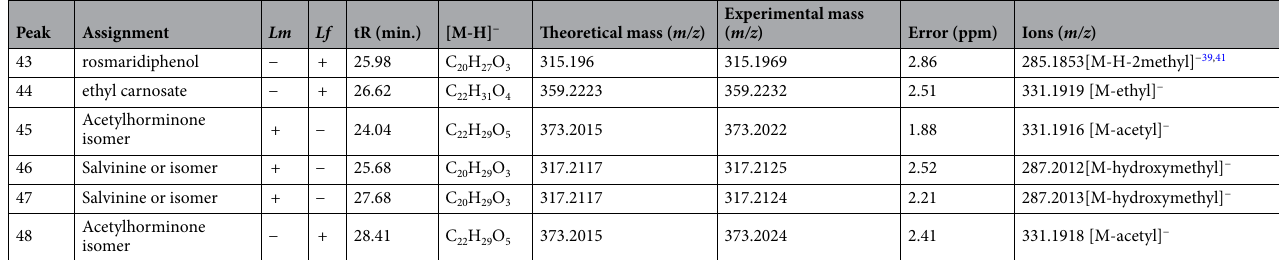
Table 1. Compounds detected in the ethanolic extract of Lepechinia meyenii Walp. (Epling) (Lm) and Lepechinia floribunda (Benth.) Epling (Lf) by